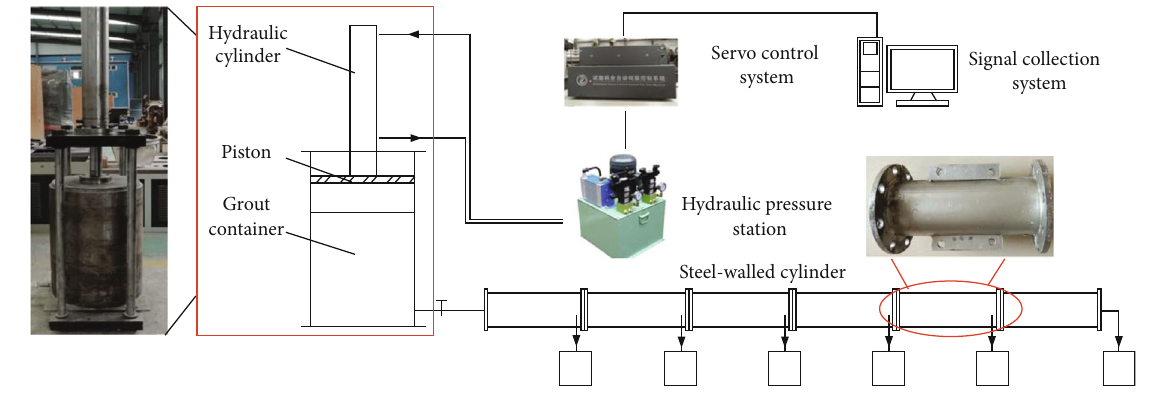
Figure 4: Schematic diagram of the test system. Table 4: Experimental